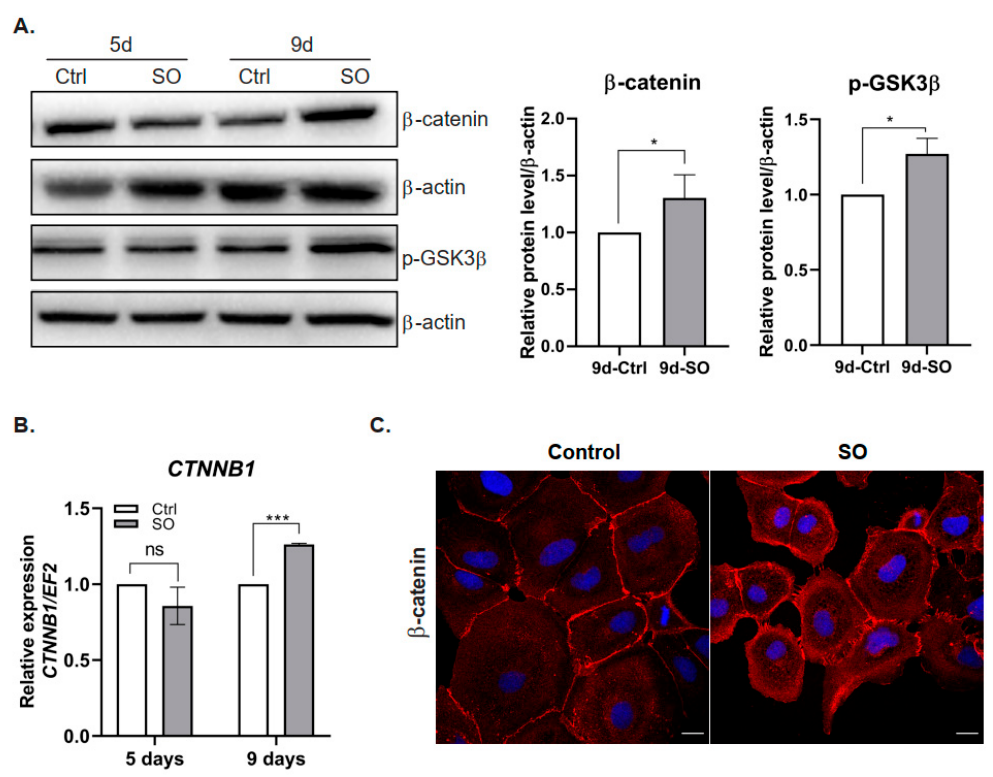
Figure 2. Effect of sodium oleate stimulation on the level of β -catenin in Huh7 cells. ( A ) Left panel, Western blot analysis of β -catenin and phosphorylated GSK3 β protein levels in the cells stimulated with sodium oleate for five and nine days; β -actin was used as the loading control. Right panel, densitometric analysis from five ( β -catenin) and three (GSK3 β ) independent repetitions: Huh7 cells after nine days of stimulation with sodium oleate, Ctrl—control, SO—0.5 mM sodium oleate. ( B ) mRNA expression of β -catenin ( CTNNB1 ) after five and nine days of stimulation with sodium oleate, Ctrl—control, SO—0.5 mM sodium oleate. Analysis was conducted in three independent experiments and mRNA level in each sample was analyzed in duplicates. The mRNA level in the control was set to 1. The EF2 gene was used as reference. ( C ) Representative images from a confocal microscope analysis of β -catenin (red) in the Huh7 cells stimulated with sodium oleate for five days. Primary antibody: mouse anti- β -catenin 1:50 (BD Biosciences), secondary antibody: Alexa Fluor 546 goat anti-mouse (Thermo Fisher Scientific, Waltham, MA, USA); Hoechst (blue) for nuclei, 63 × magnification, scale bar, 20 µ m. The results are presented as the means ± SD, the Student’s t -test was used to determine the p -value, * p < 0.05, *** p < 0.001,